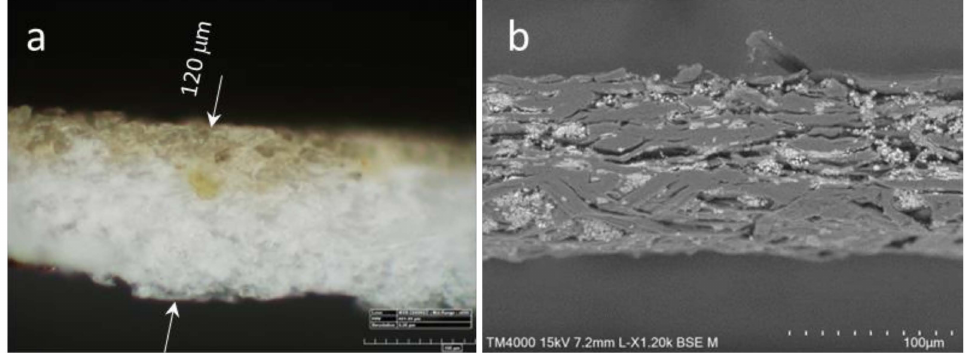
Figure 7. Cross-sectional optical micrograph of a handsheet (HS) coated by CL and LS (CL + LS) ( a ) and SEM image of the HS surface ( b ).